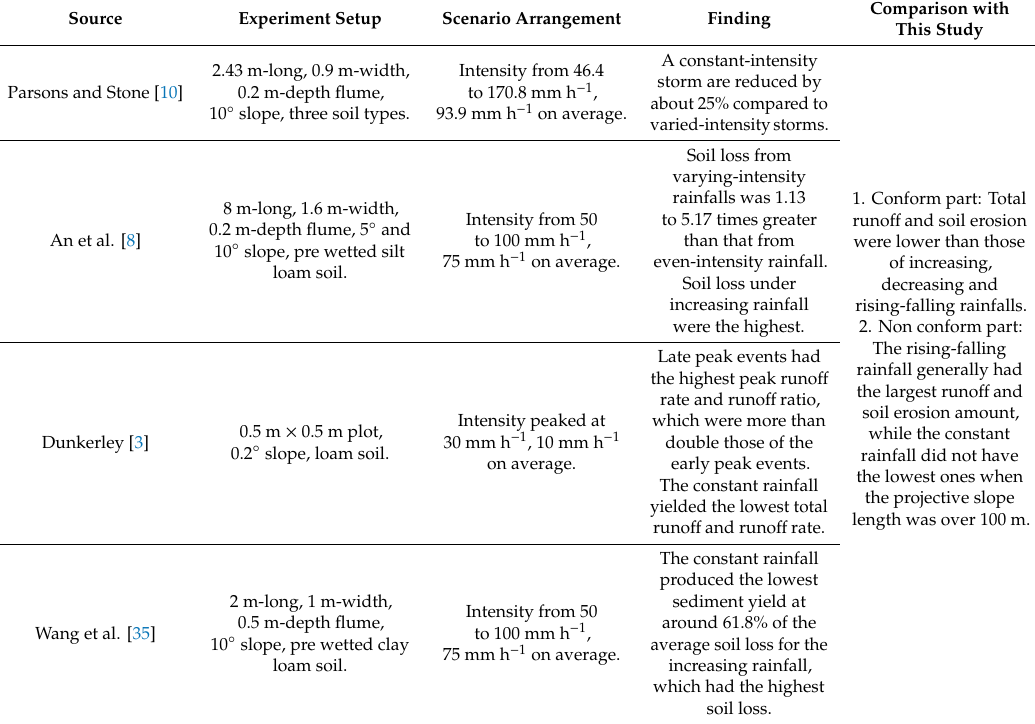
Table 4. Comparison of the findings between the current and previous